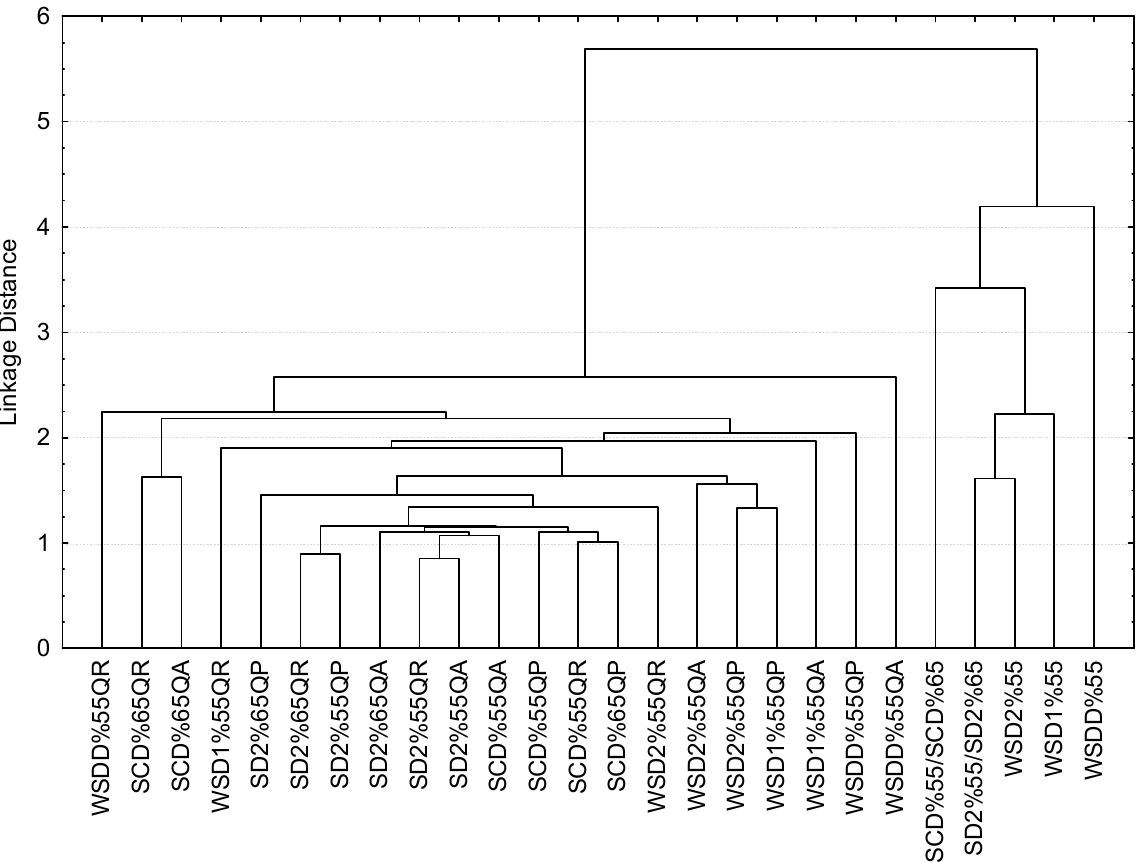
Figure 3. Tree graph representing the cluster analysis of the brandies applied to sensory data.